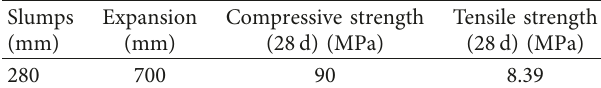
Table 2: Physical and mechanical parameters of